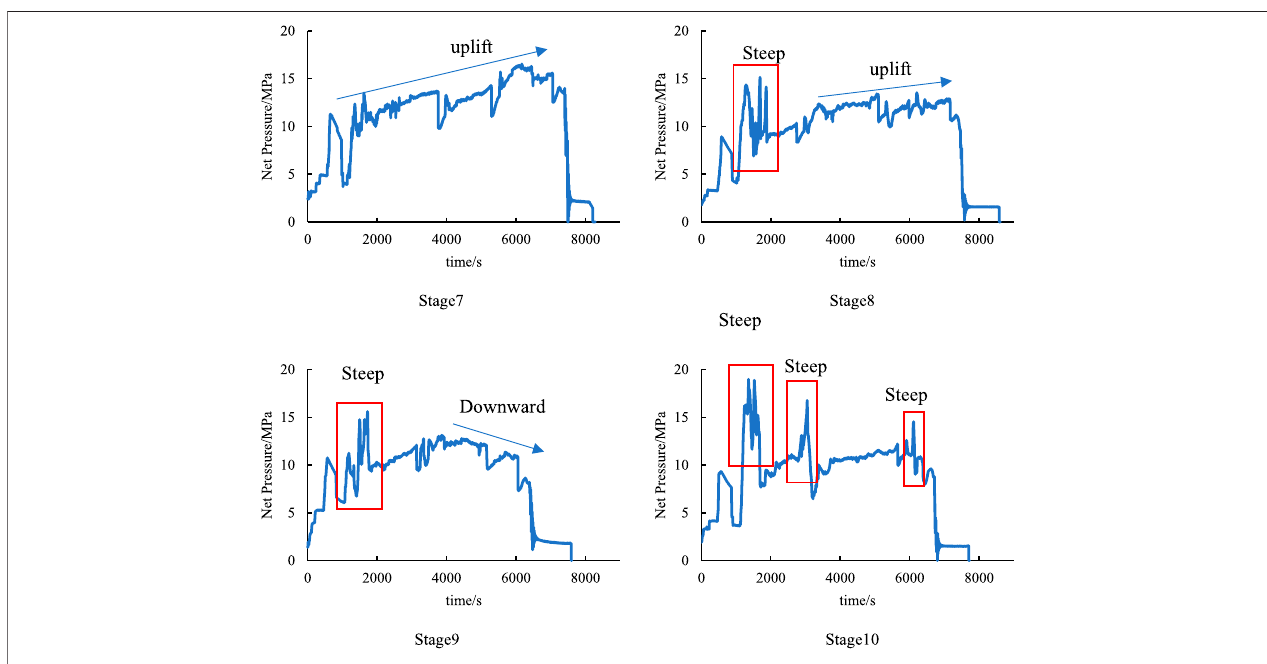
FIGURE 7 | Net pressure curves for stages 7 through 10 of well H7 – 4.